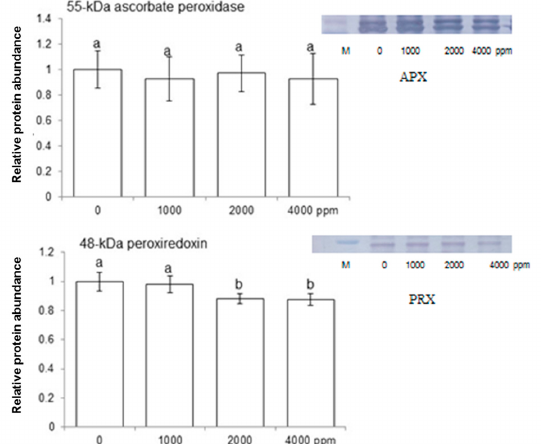
Figure 6. Effect of plant-derived smoke on redox-homeostasis related proteins in maize. Maize seeds were treated without or with 1000, 2000, and 4000 ppm plant-derived smoke for 6 h and grown for 4 days. Proteins extracted from shoot were separated by SDS-polyacrylamide gel electrophoresis and transferred onto polyvinylidine difluoride membranes. The membranes were incubated with anti-RuBisCO large/small subunits and anti-RuBisCO activase antibodies. The relative intensities of bands were calculated using ImageJ software. Data are shown as means ± S.D. from 3 independent biological replicates. Different letters indicate that the change is statistically significant as determined by one-way ANOVA followed by Tukey’s multiple comparison ( p < 0.05). In images, “M” is used for